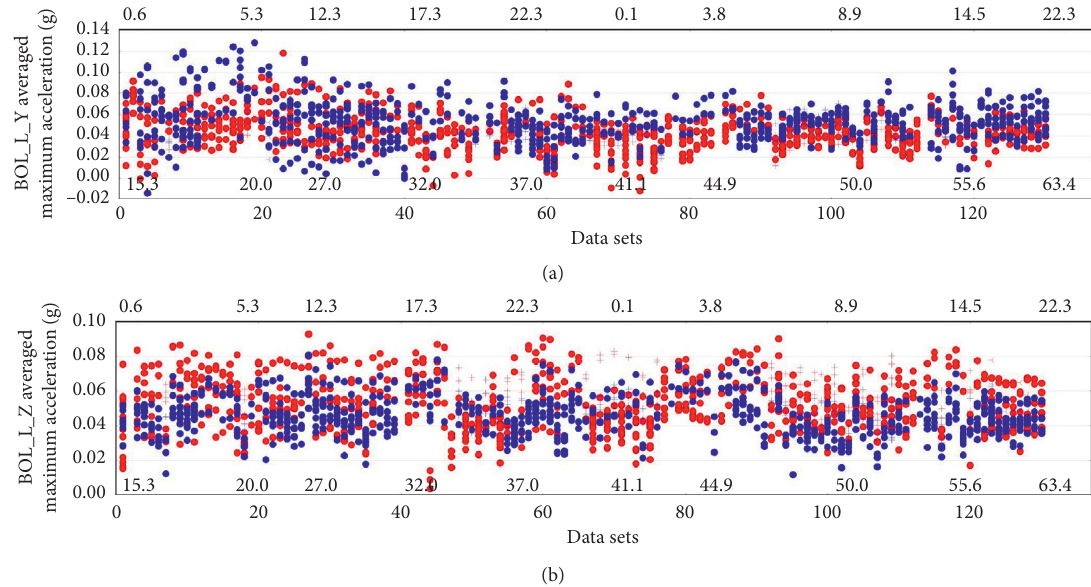
Figure 8: Evolution of the low-pass filtered (15Hz) acceleration on the CB chassis in (a) lateral and (b) vertical directions.